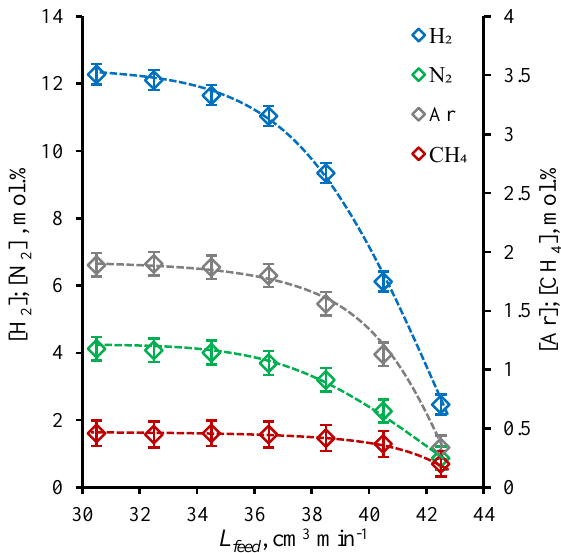
Figure 5. The H 2 , N 2 , Ar, and CH 4 concentration (mol%) in permeate flow under a helium sweep of cell’s bore as a function of feed flow rate (cm 3 min − 1 ) during a steady-state ammonia capture process.